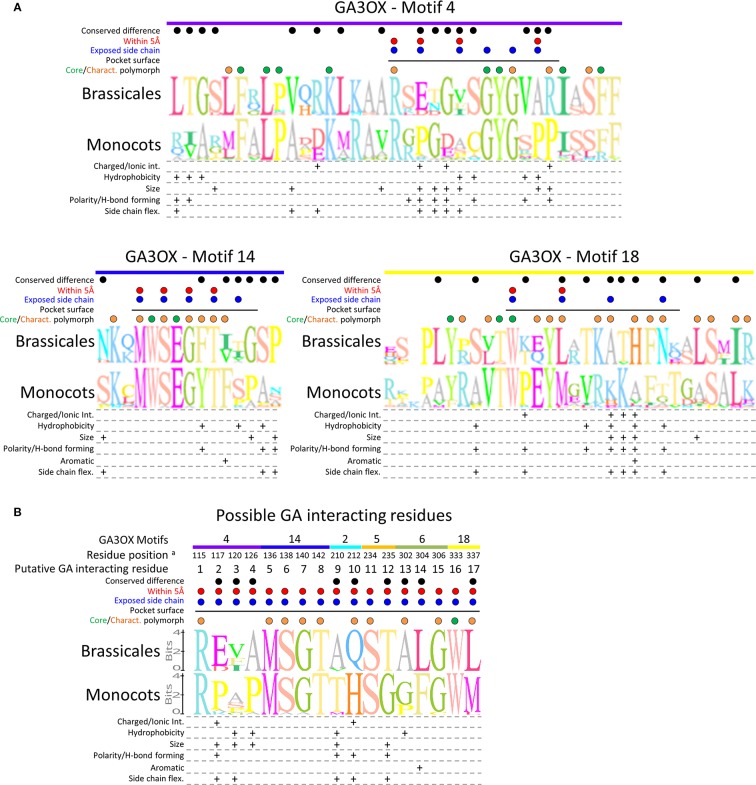
Comparing protein sequences of the GA docking pocket between monocots and Brassicales GA3OX proteins. (A) Sequence logo alignments comparing the GA3OX-specific motifs forming the GA docking pocket, with differences in biochemical properties of the conserved substituted amino acids below. (B) Sequence logo alignments comparing the putative GA contact residues within the GA3OX GA docking pocket, with differences in biochemical properties of the conserved substituted amino acids below. Sequence logos: the overall height of the residue logo stack indicates the sequence conservation at that position, whereas the height of the given residue reflects the relative frequency of the corresponding amino acid. The motifs from which each of the interacting residues originate are indicated along the top of the alignments; color coding and motif labels are concordant with Figure 6C. Dots above the sequences: green—core residues conserved across all GAOX classes, orange—conserved polymorphisms characteristic (Charact.) of GA3OX proteins, blue—pocket lining residues with reactive side chains orientated inwards toward the substrate, red—same as blue marked residues, except within 5Å of docked GA molecule, black—conserved polymorphic residues between monocot and Brassicales. Black solid horizontal line: Residues of the motif that line the interior surface of the GA docking pocket. Amino acid property groups used to characterize the biochemical properties of the conserved substituted amino acids: charged resides (capable of forming ionic interactions): positive [R, H, K], negative [D, E], uncharged [A, N, C, Q, G, I, L, M, F, P, S, T, W, Y, V]. Hydrophobicity: hydrophobic [I, L, V, C, A, M, F], neutral/hydrophilic [G, Y, W, H, K, T, R, E, Q, D, N, S, P]. Size: small [A, G, C, S], medium [V, T, N, P, D], large [Q, E, H, K, R, F, Y, W, M, I, L]. Polarity (capable of forming H-bonds): charged polar [H, R, K, E, D], uncharged polar [Q, T, S, N, Y, W], non-polar [A, G, V, L, I, P, F, M]. Side chain flexibility: high [K, E, M, Q, R], moderate [D, F, H, I, L, N, W, Y], low [C, S, T, V], limited [A], restricted [P]. Sequences: monocot GA3OXs; TaeGA3OX-B2 (wheat), HvuGA3OX2 (barley), Sit5G125501 (Setaria), PvirJ243921 (Panicum), Sbi003G0459001 (Sorghum), Msi05G0336001 (Miscanthus), ZmaNP_001266453 (Maize), OsaGA3OX2 (rice), Bdi2G04840 (Brachypodium), OsaGA3OX1 (rice), Sit025127 (Setaria), ZmaNP_001146525 (Maize), and Sbi005400 (Sorghum). Brassicales GA3OXs; RrGA3OX1a (wild radish), Bra026757 (Brassica rapa), RrGA3OX1b (wild radish), Bra026122 (Brassica rapa), Tha008008 (Thellungiella halophile), Cru0009532 (Capsella rubella), Aly471756 (Arabidopsis lyrata), AthGA3OX1 (Arabidopsis thaliana), AthGA3OX2 (A. thaliana), Aly909680 (Arabidopsis lyrata), RrGA3OX2a (wild radish). For sequences, see Supplementary Tables S2–S4. For their phylogenetic relationships, see Supplementary Figure 8. aResidue position in relation to the RrGA3OX1a sequence in Figure 7.